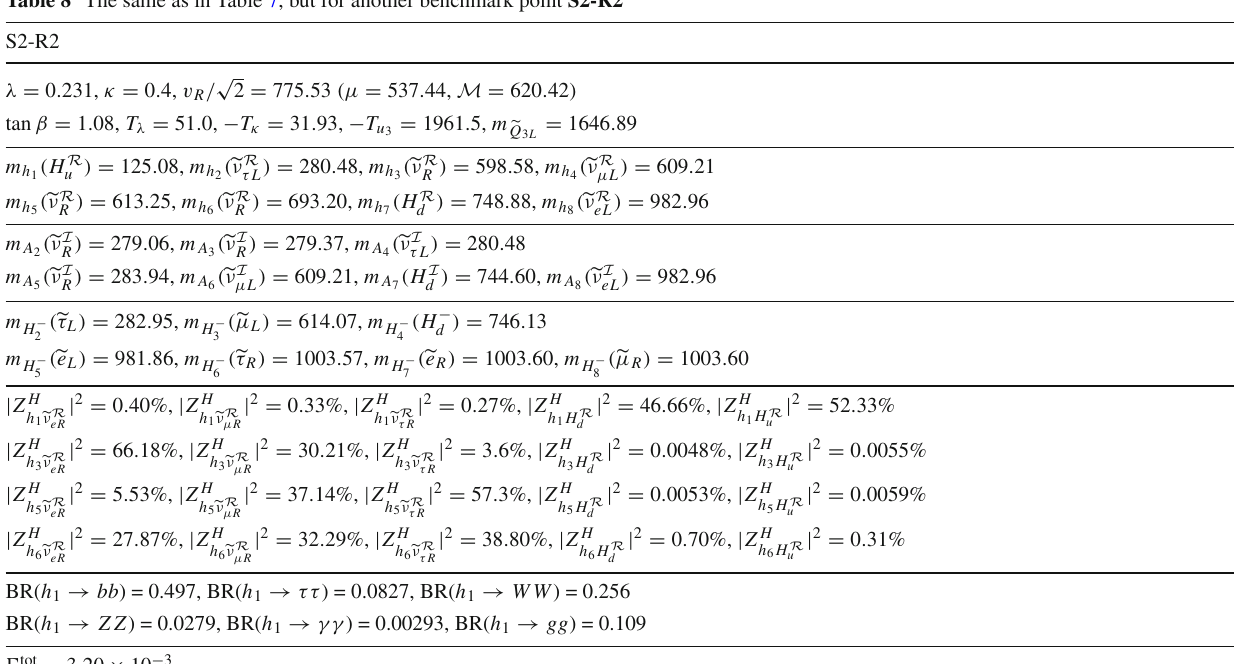
√ / 2 = 775 . 53 (μ = 537 . 44, M = 620 . 42 R